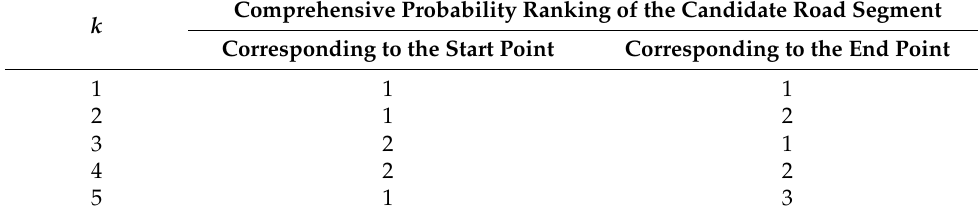
Table 1. k cases of candidate paths.